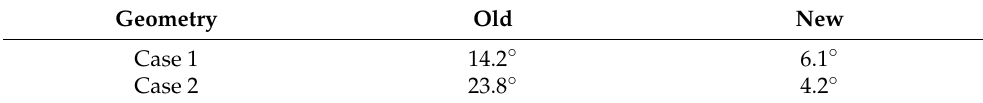
Table 8. Flow orientation misalignment at the leading edge of the stay vanes of case 1 and 2.